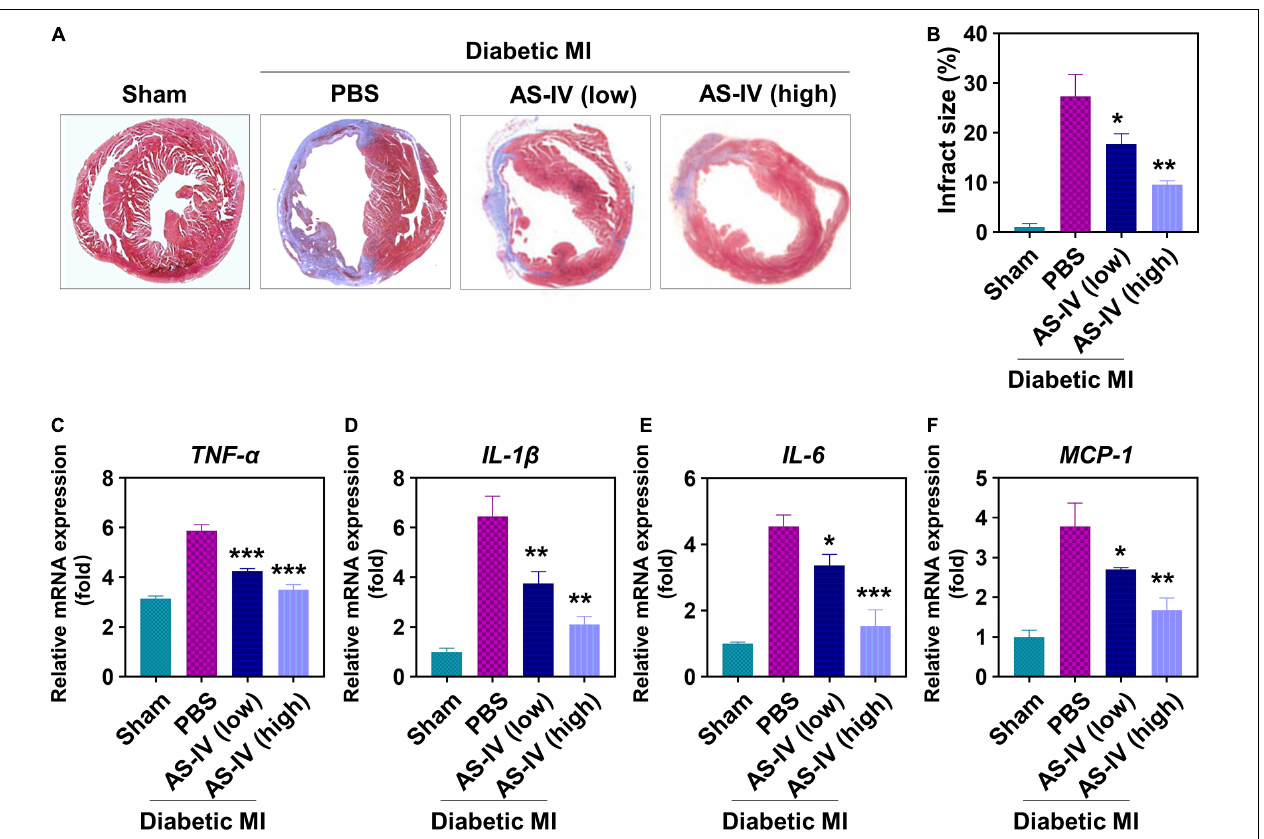
FIGURE 4 | Effects of AS-IV on cardiac fibrosis and inflammation in post-MI diabetic mice. (A) Representative Masson’s trichrome-stained myocardial sections in hearts. Blue, scar tissue; red, viable myocardium. (B) Quantitation of infarct size in the four indicated experimental groups. Data represent means ± SD. ** p < 0.05; ** p < 0.01. n = 6 biologically independent mice. Quantitative analysis of mRNA expression of proinflammatory cytokines and chemokines, including TNF- α (C) , IL-1 β (D) , IL-6 (E) , and MCP-1 (F) , in the border zone of infarct at 1 week post-MI. mRNA expression normalized to GAPDH expression of the same group. Data represent means ± SD. * p < 0.05; ** p < 0.01; *** p < 0.001, n = 6 biologically independent